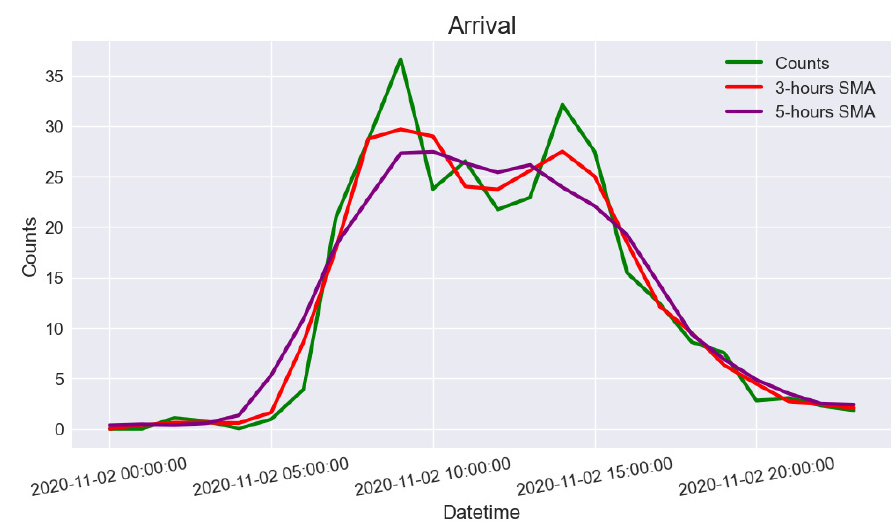
Figure 8. Sample of the vehicle flow after the SMA.